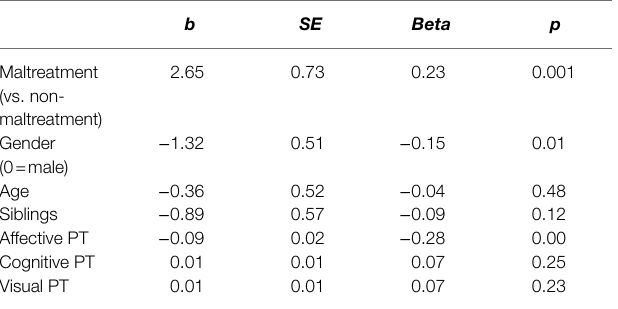
TABLE 5 | Linear Regression Model II: aggressive behaviors. TABLE 6 | Perspective taking assessment tasks: pre-test and post-test (Study